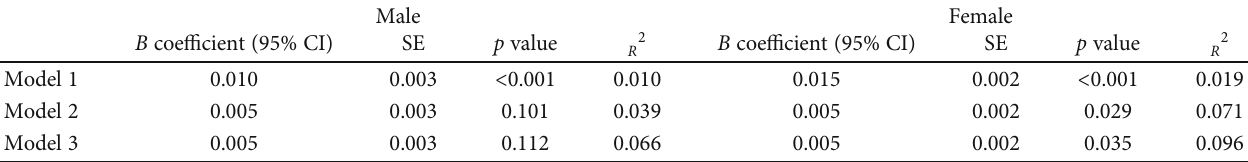
β coe ffi cients are estimated values in mg/dL re fl ecting the complex sample weight. Model 1 on both categories is the unadjusted model. Model 2 is adjusted by age, gender, mean SBP, triglycerides, sedentary hours a day, binge drinking frequency, waist circumference, and smoking state. Model 3 is added by adjusting WBC in Model 2. SE: standard